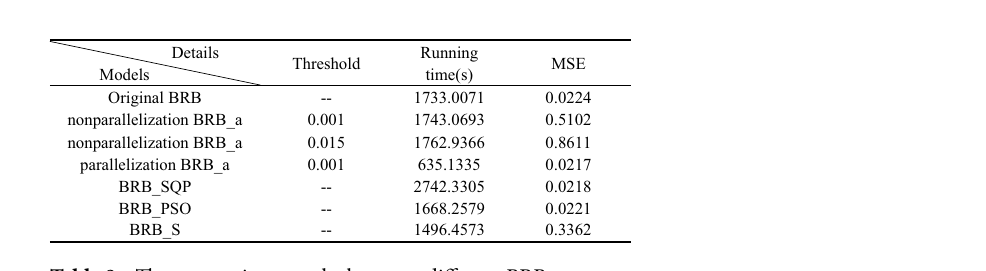
Table 9. The comparison results between different